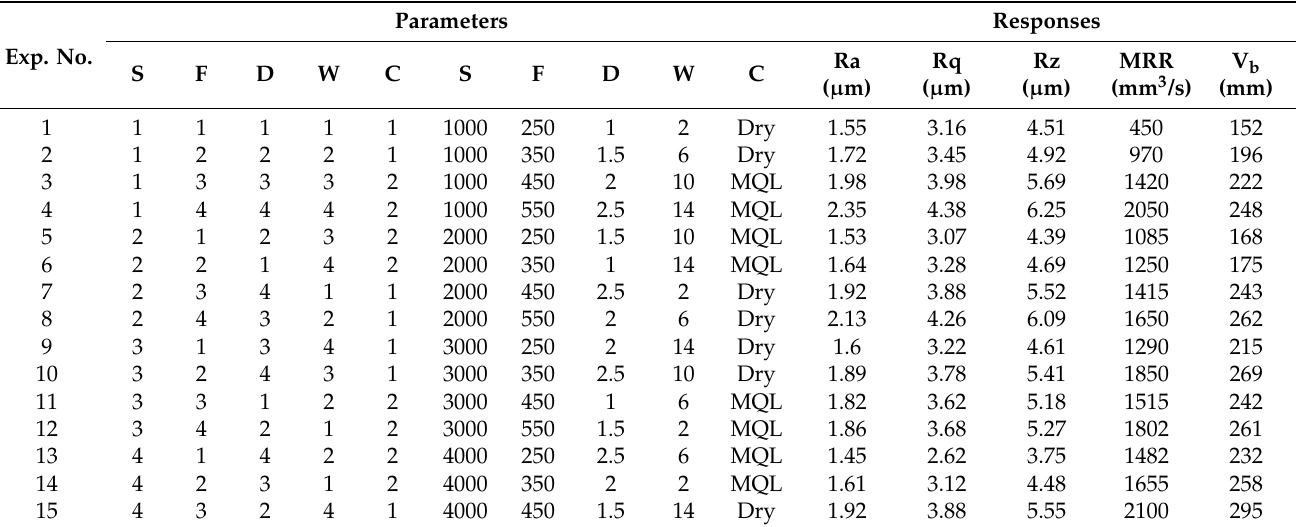
Table 4. Design matrix in coded and experimentation results.